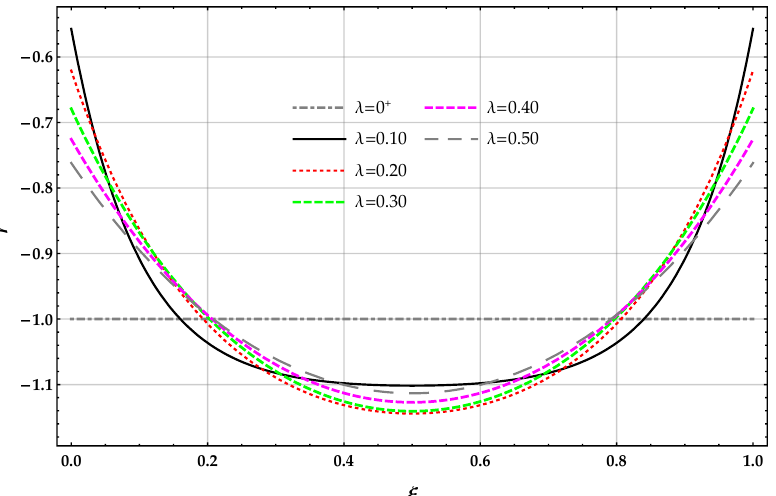
Figure 3. FF − q beam. DD method: plots of the non-dimensional reaction r ∗ of the elastic foundation for increasing values of the non-dimensional non-local parameter λ in the set with k ∗ =